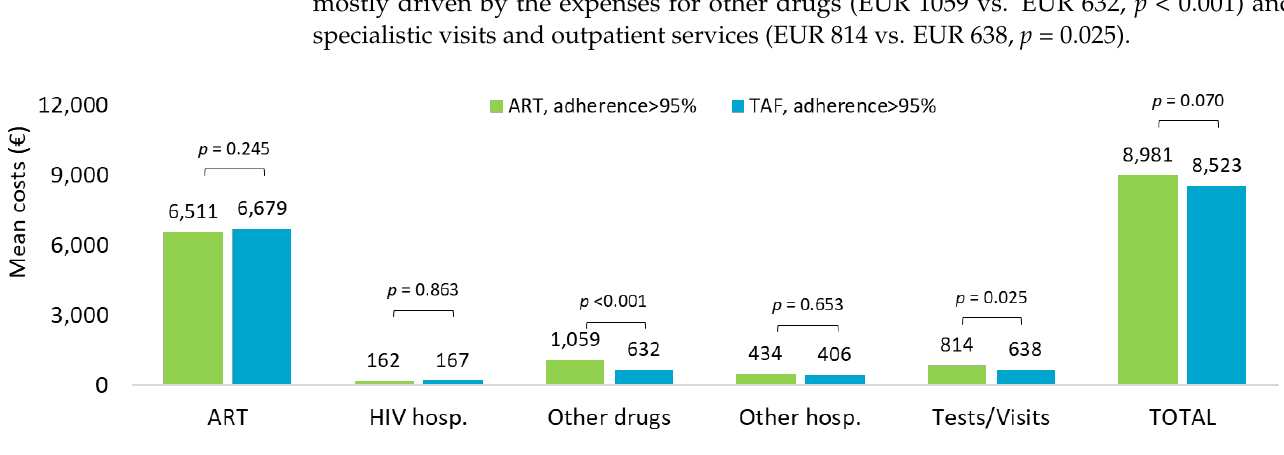
Figure 4. Mean annual health care costs (EUR) during all available follow-up for patients with ART- and TAF-based regimens and based on adherence (PDC > 95%).